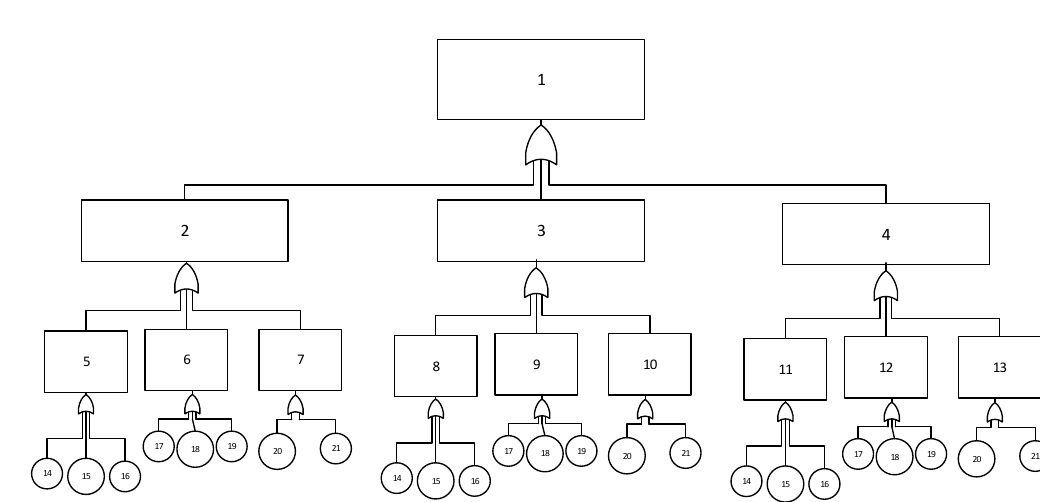
Figure A8. Fault tree of pool cooling failure. Note: 1 = pool cooling fail. 2 = JNA 10 fail. 3 = JNA 20 fail. 4 = JNA 30 fail. 5 = pump JNA 10 AP-01 fail. 6 = blower JNA 10 BC-02 fail. 7 = heat exchanger JNA 10 BC-01 fail. 8 = pump JNA 20 AP-01 fail. 9 = blower JNA 20 BC-02 fail. 10 = heat exchanger JNA 20 BC-01 fail. 11 = pump JNA 30 AP-01 fail. 12 = blower JNA 30 BC-02 fail. 13 = heat exchanger JNA 30 BC-01 fail. 14 = pump fails to start (B18). 15 = pump fails to operate after start (B19). 16 = operator fail to operate pump (B7). 17 = blower fail start (B20). 18 = blower fail after start (B21). 19 = operator fail to operate blower (B7). 20 = heat exchanger clogged (B22). 21 = heat exchanger leaked (B23).